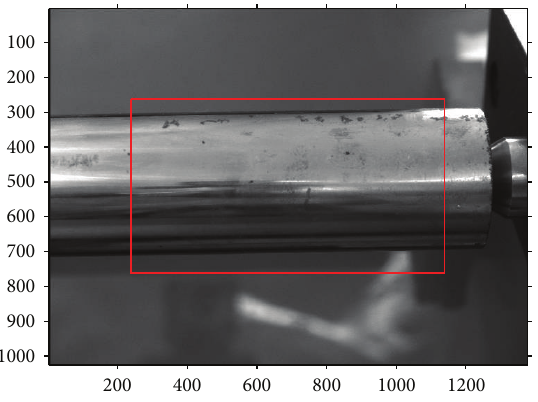
Figure 7: The measurement region of shaft